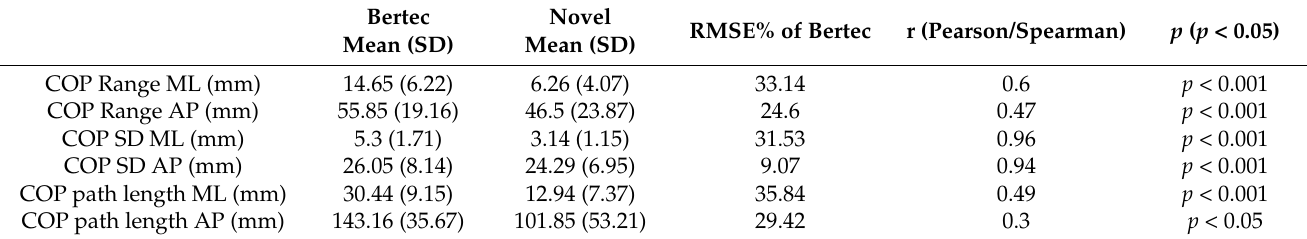
Table 4. Results of the comparison between the COP displacement recorded through the force plates and the plantar pressure system: RMSE% and Pearson/Spearman’s correlation coefficient. Statisti ‐ cally significant values are reported as p < 0.05. ML = medial/lateral, AP = anterior/posterior.